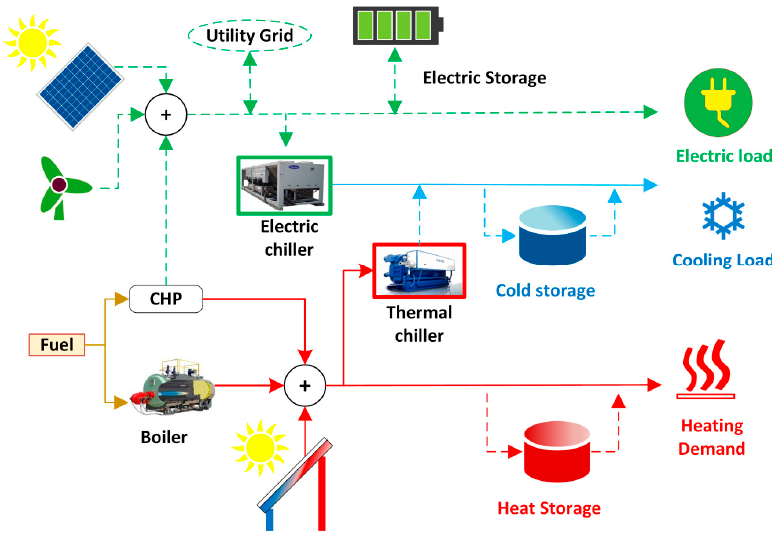
Figure 2. Block diagram of the polygeneration system [13,19].